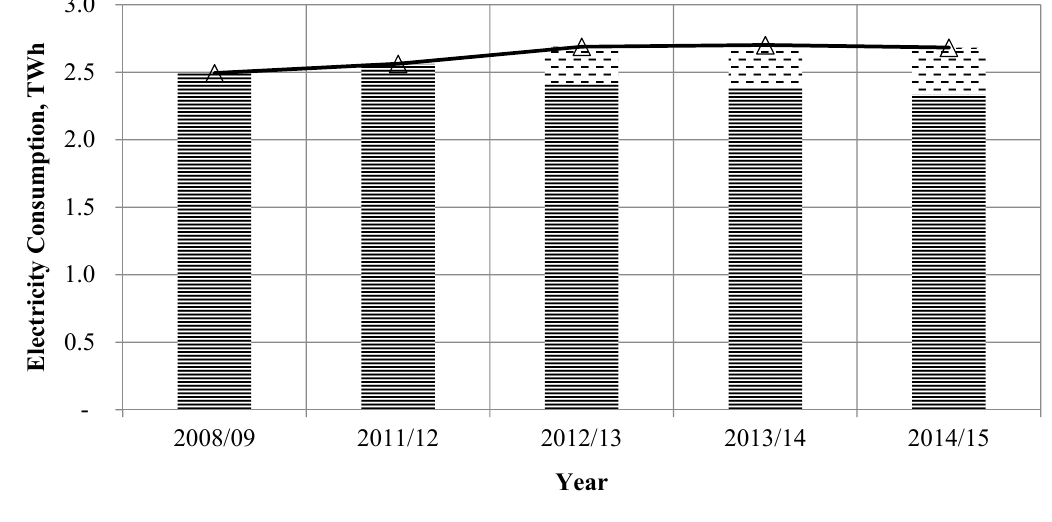
Figure 2. Variation of annual electricity consumption of England’s HE sector [4].